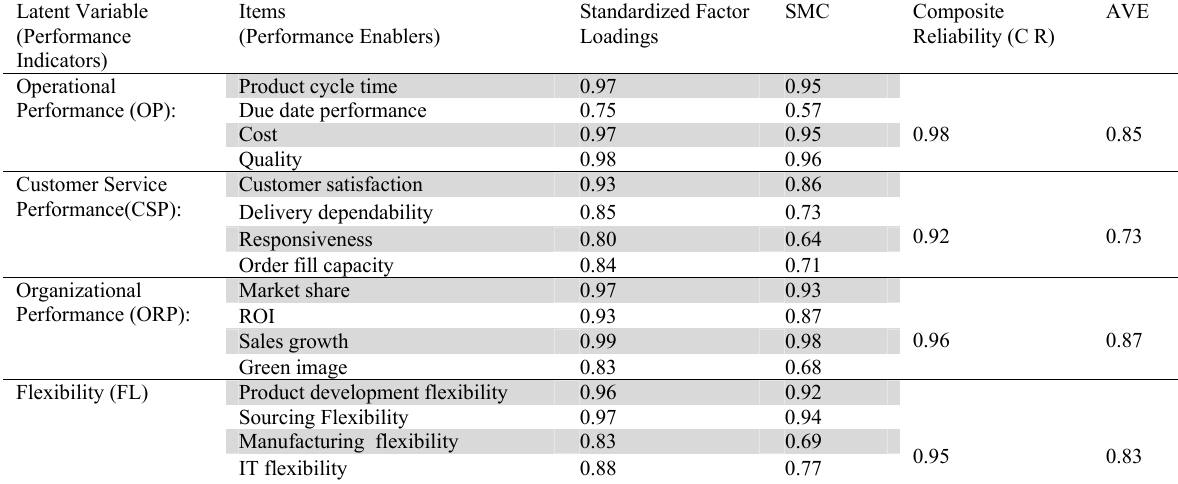
Reliability and validity analytical results of measurement model